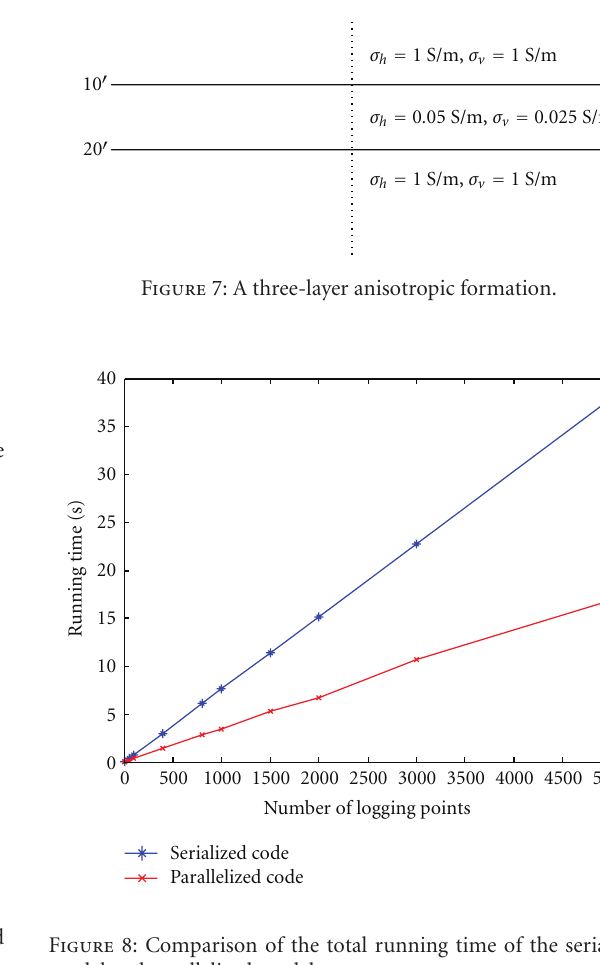
Figure 8: Comparison of the total running time of the serialized model and parallelized